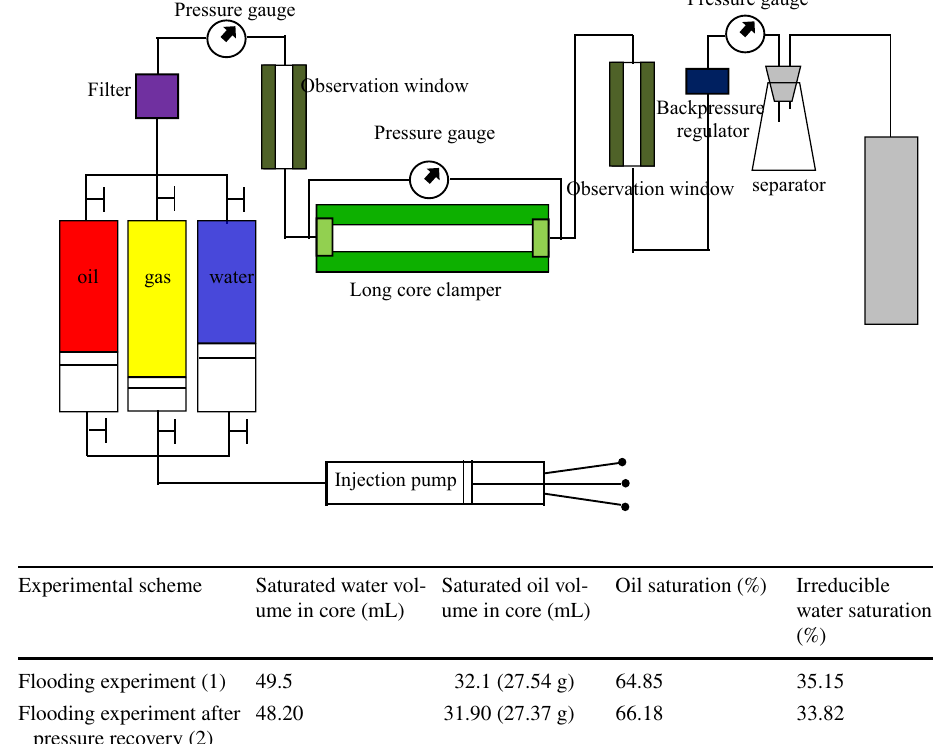
Fig. 1 CO 2 -flooding experimen- tal device